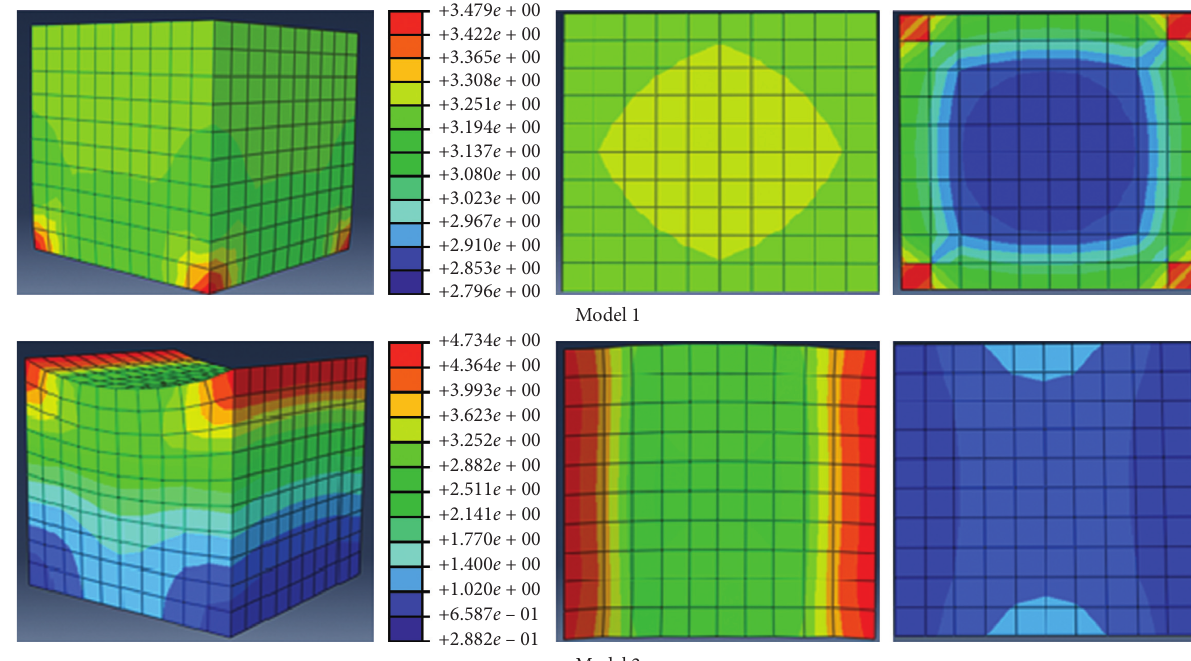
Figure 7: Results of the mathematical modeling for REF129